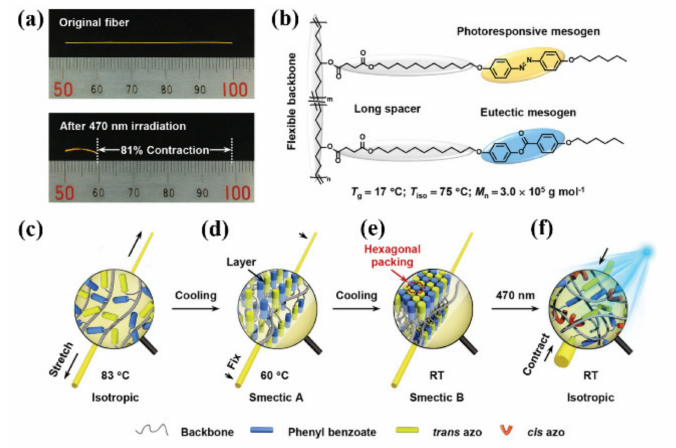
Figure 8. ( a ) Photographs showing light-driven contraction up to 81% of the azo LLCP fiber upon irradiation with 470 nm light (100 mW cm − 2 ). ( b ) Molecular structure of a newly designed azo LLCP. T g , glass transition temperature; T iso , isotropic transition temperature; M n , number-average molecular weight. ( c – f ) Schematics showing the fabrication procedure of the azo LLCP fiber with highly ordered liquid crystal phase and mechanism of the light-driven ultralarge contraction based on trans – cis isomerization of azo mesogens. RT, room temperature. Reprinted with permission from Reference [58]. Copyright 2020